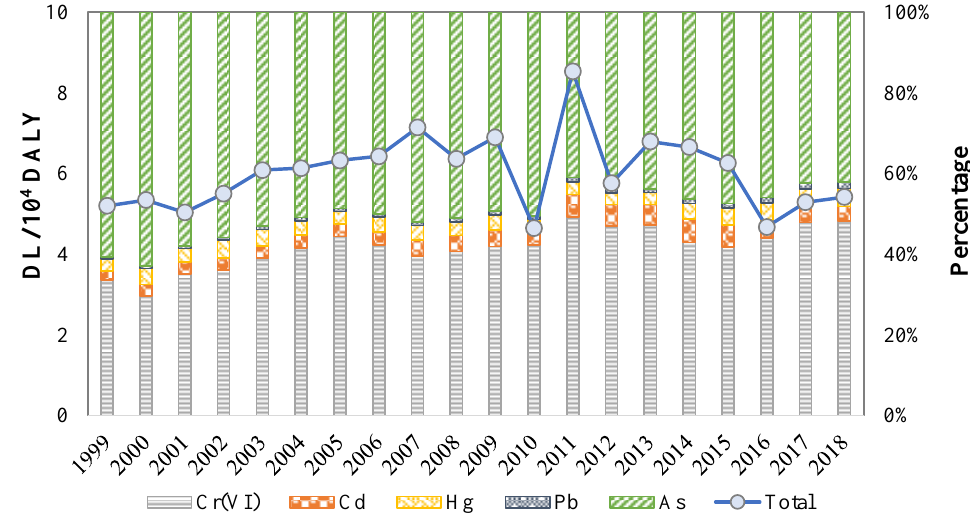
Figure 2. The DL of heavy metal emissions from industrial wastewater in 1999–2018.